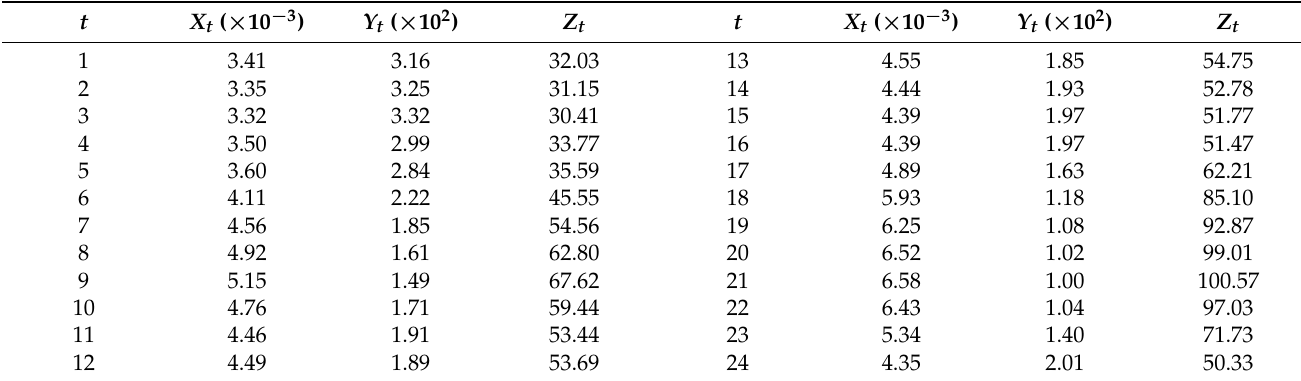
Table 2. Coefficients in Figure 5 (the day of the highest electricity consumption).